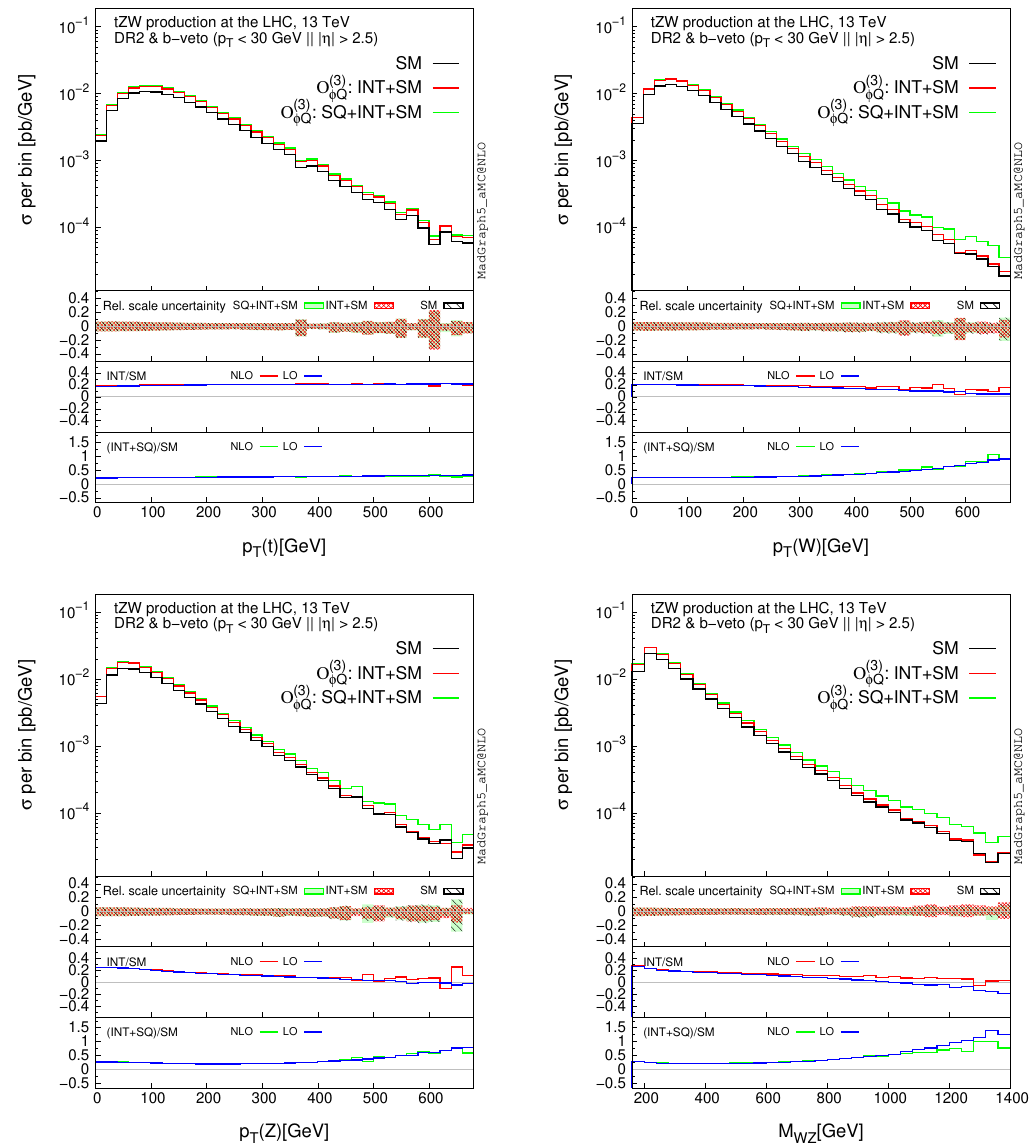
Figure 9 . Clockwise from top left: the transverse momentum of the (anti-)top quark, p T ( t ) , of the W ± boson, p T ( W ) , the invariant mass of the WZ pair, M WZ , and the transverse momentum of the Z boson, p T ( Z ) at DR2 for the O (3) SMEFT operator when t ¯ tZ is removed and b -veto is imposed, ϕQ at fixed order NLO accuracy. The legends correspond to different computations at different SMEFT contributions. The first inset shows the scale variations in the process, while the middle and the last insets show (at LO and at NLO) the interference and the full SMEFT contribution relative to the SM, respectively. The relative scale uncertainties are computed on the summed cross sections and not separately on the interference and the quadratic SMEFT